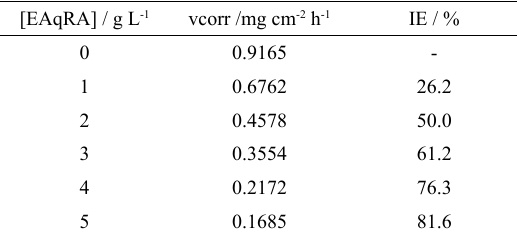
Table 1. Corrosion rate and inhibitory efficiency to stainless steel SO 1.5 mol L -1 in presence and absence of AISI 304 in H 2 4